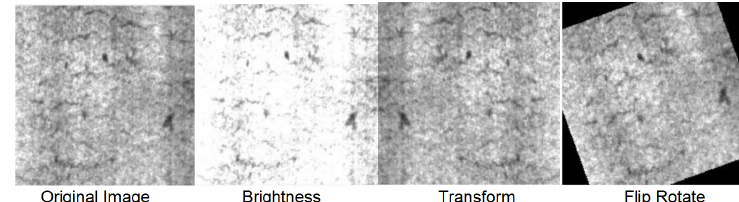
Figure 9. Enhanced images of the steel dataset.